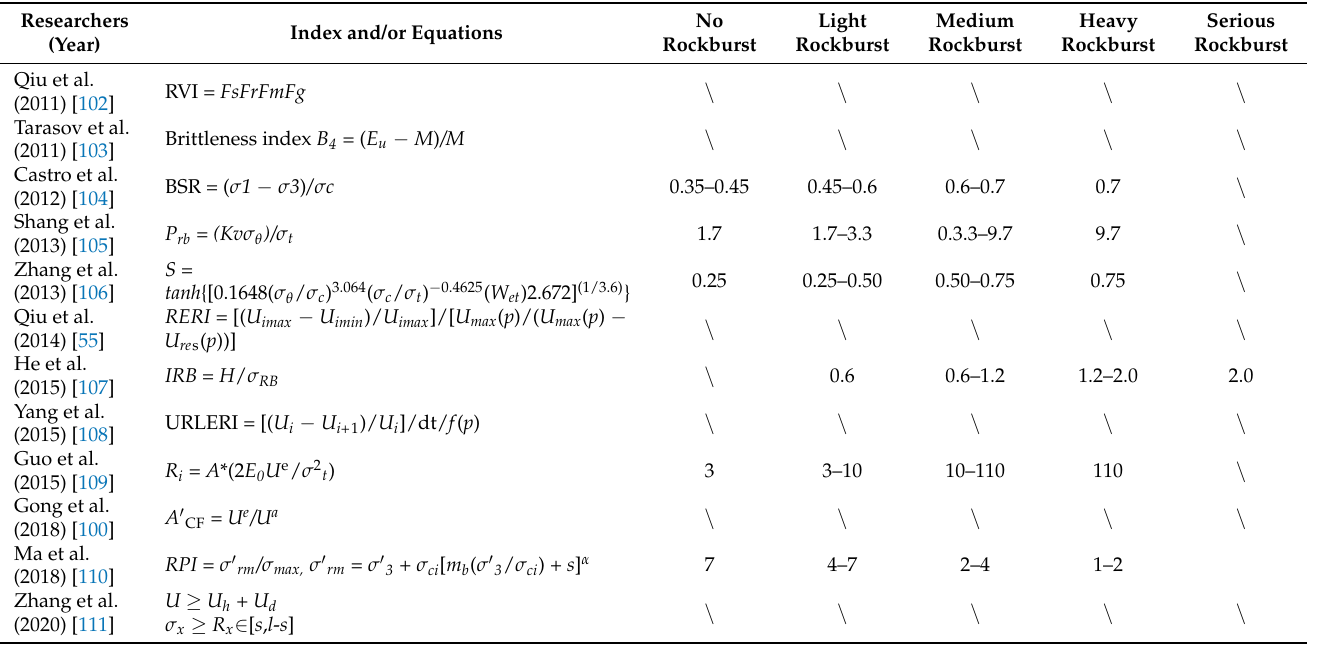
Table 4. Rockburst criteria and valuation of qualitative indices of rockburst classification (modified from